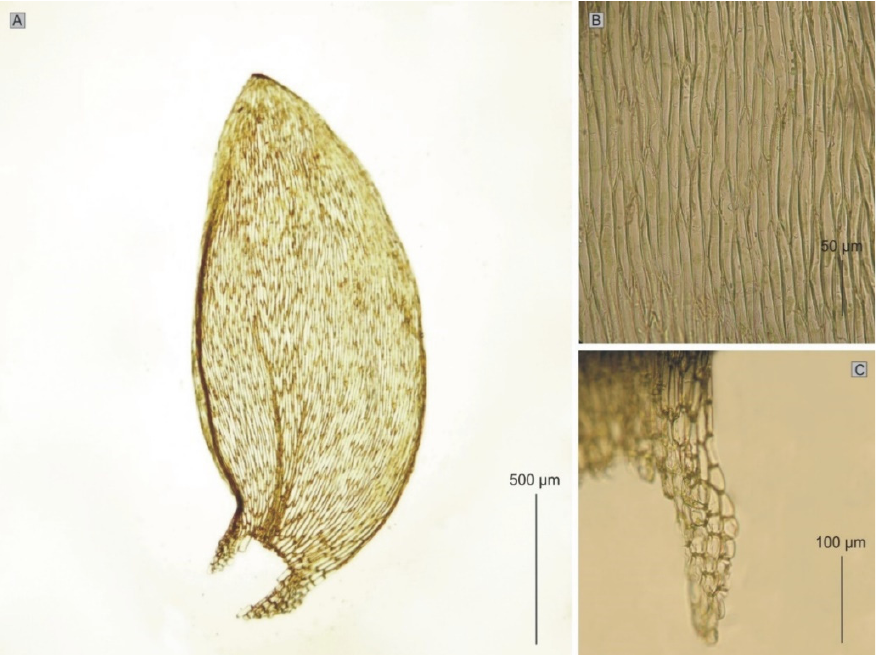
Figure 14. The most important taxonomic features of P. denticulatum var. auritum: ( A ) leaves; ( B ) cells from the middle part of leaves; ( C ) decurrent cells (photo from PC0132639 by G.J. Wolski, Paris, November 2021).